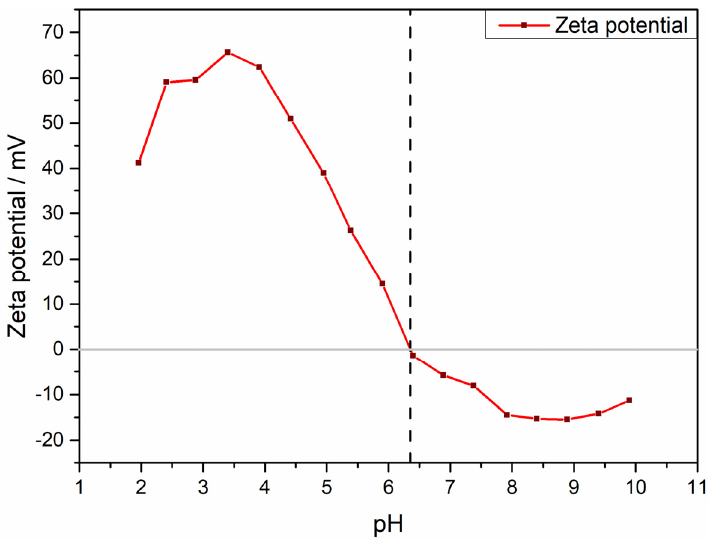
Figure 6. Zeta potential measurement of an aqueous solution of BFO in the pH range from 2–10.